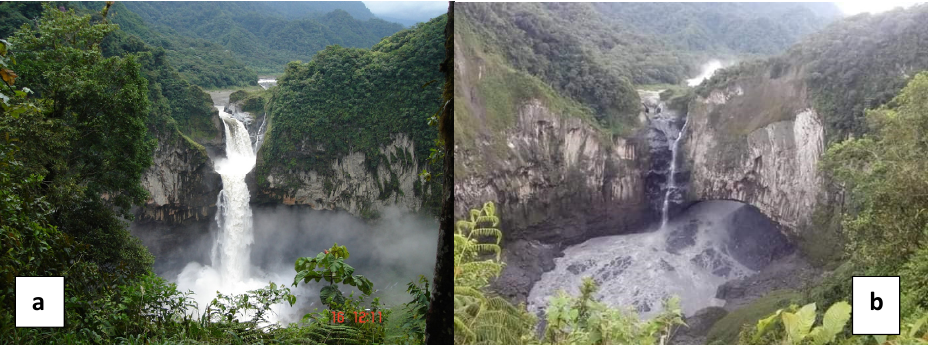
Figure 2. The San Rafael waterfall at the terminus of the Quijos river. ( a ) The left image is the historical flow and scenic beauty of the tallest waterfall in Ecuador. ( b ) The right image shows the change in the current flow that responded to natural causes of erosion; however, there are hints reflecting intensive manipulation of the riverine areas for the Coca-Codo Sinclair hydroelectric megaproject nearby. Source ( a ): Photo from Neotropical Montology Collaboratory, 16 December 2011. Source ( b ): Photo from Jack Rodríguez, 12 August 2021.